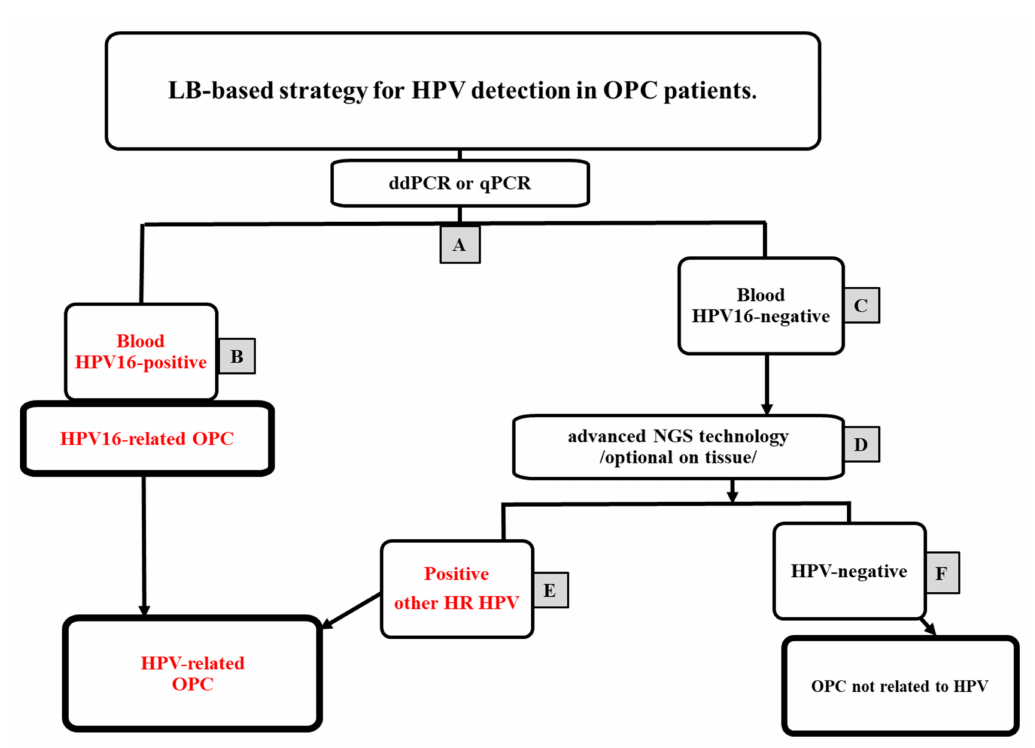
Figure 1. The identification of HPV-related cancer by liquid biopsy in the primary diagnosis of a patient with oropharyngeal cancer (OPC). ( A ) In the first line of molecular diagnostics, the use of a fast, simple, and inexpensive ddPCR or qPCR technique enables the detection of the most common HPV16 virus in the LB; ( B ) a positive HPV16 result indicates an HPV16-related OPC; ( C ) a negative ddPCR/qPCR result is an indication for in-depth molecular diagnostics, due to the possibility of other HR HPVs; ( D ) the use of more expensive and complex NGS-based molecular diagnostics gives the best chance of detecting other types, preferentially performed in a LB (or optionally on scraps); ( E ) a positive HR ctHPV result in NGS indicates an HPV-related OPC; and ( F ) a negative NGS test result indicates a disease independent of the HPV